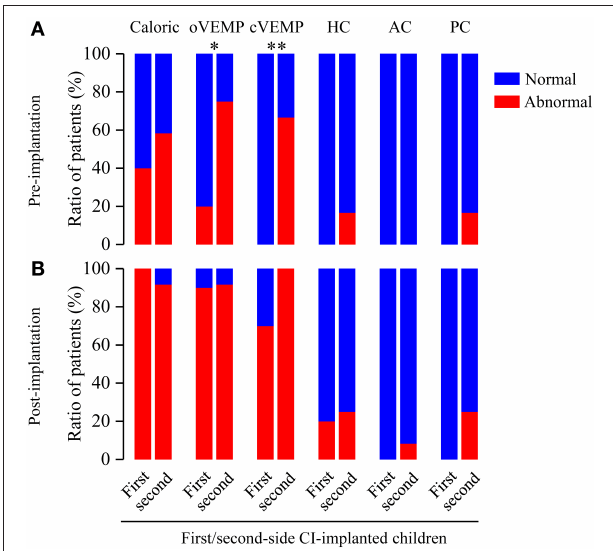
FIGURE 4 | Ratio of patients with abnormal vestibular functions revealed by pre- and post-implantation caloric test, VEMP test and vHIT in first- and second-side CI-implanted children. (A) Higher abnormal rates for pre-implantation oVEMP and cVEMP were found in first-side CI-implanted children than in second-side CI-implanted children. (B) Post-implantation tests showed no significant difference of abnormal rates between these two groups. * p < 0.05, ** p <